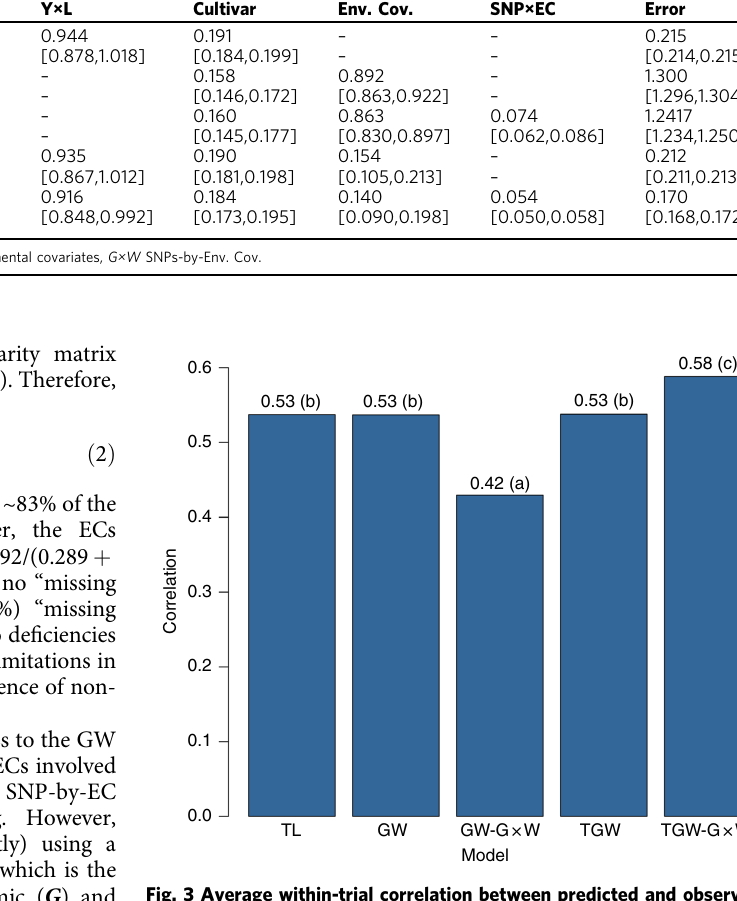
Fig. 3 Average within-trial correlation between predicted and observed yield. Results were obtained with a ‘ leave-trial-out ’ cross-validation. Letters indicate differences at the 0.01 signi fi cance level. TL: year-location + cultivar ID (baseline model), GW incorporates the main effects of SNPs and of EC. GW-G×W adds to GW interactions between SNPs and EC. TGW includes year-location, SNP, and EC effects. TGW-G×W expands TGW by adding SNP-EC